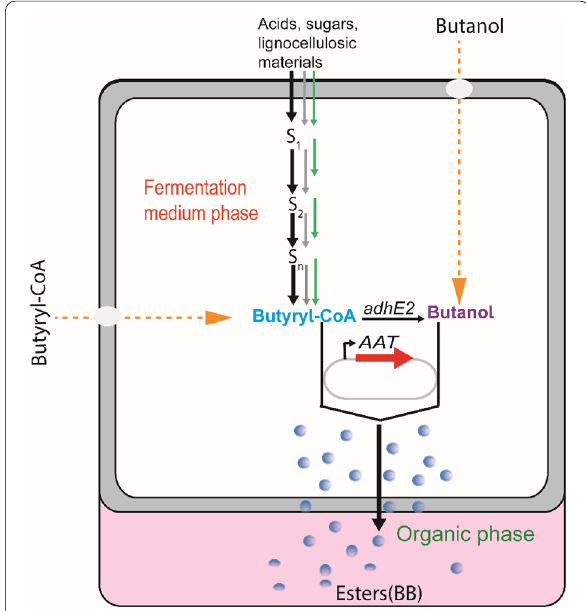
Fig. 2 Combinatorial approaches attempted in single strain for BB biosynthesis. Black color denotes the native pathways responsible for butyryl-CoA and/or butanol accumulation through intracellular acyl-CoA molecules (in Clostridia species). The grey color shows the pathway optimizations by either overexpressing downstream acyl-CoA enzymes or introducing new enzymes with higher activity. Green color indicates the heterologous pathways aiming at improving the intracellular butyryl-CoA molecule for high butyrate and butanol availability (often in E. coli ). In some cases, butyryl-CoA and/or butanol are supplemented in the fermentation system. The blue circles indicate BB produced. AAT modules should be introduced to catalyze the esterification reaction of butyryl-CoA with butanol into biosynthetic BB. adhE2 (aldehyde/alcohol